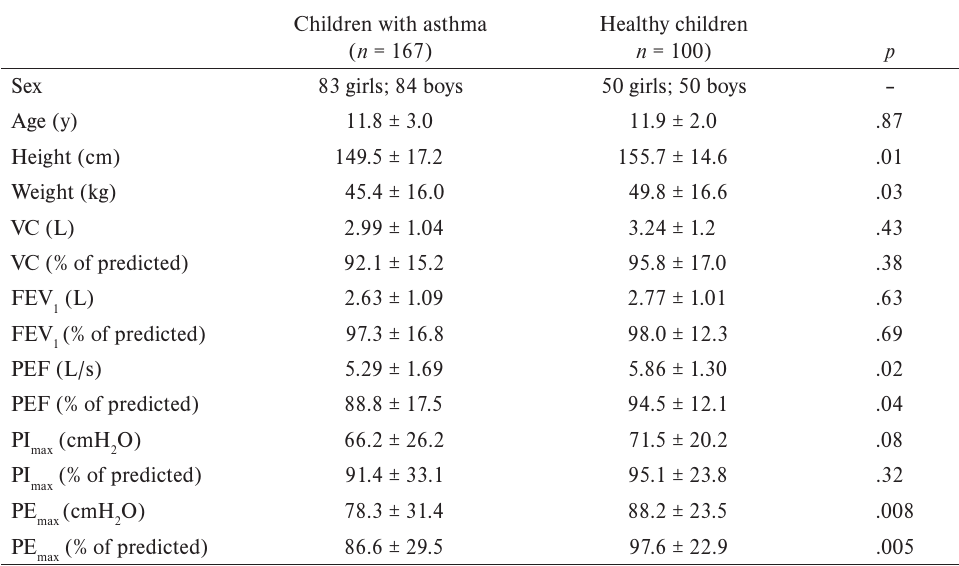
Table 1 Baseline characteristics of the studied groups (mean ± SD or number) Children with asthma